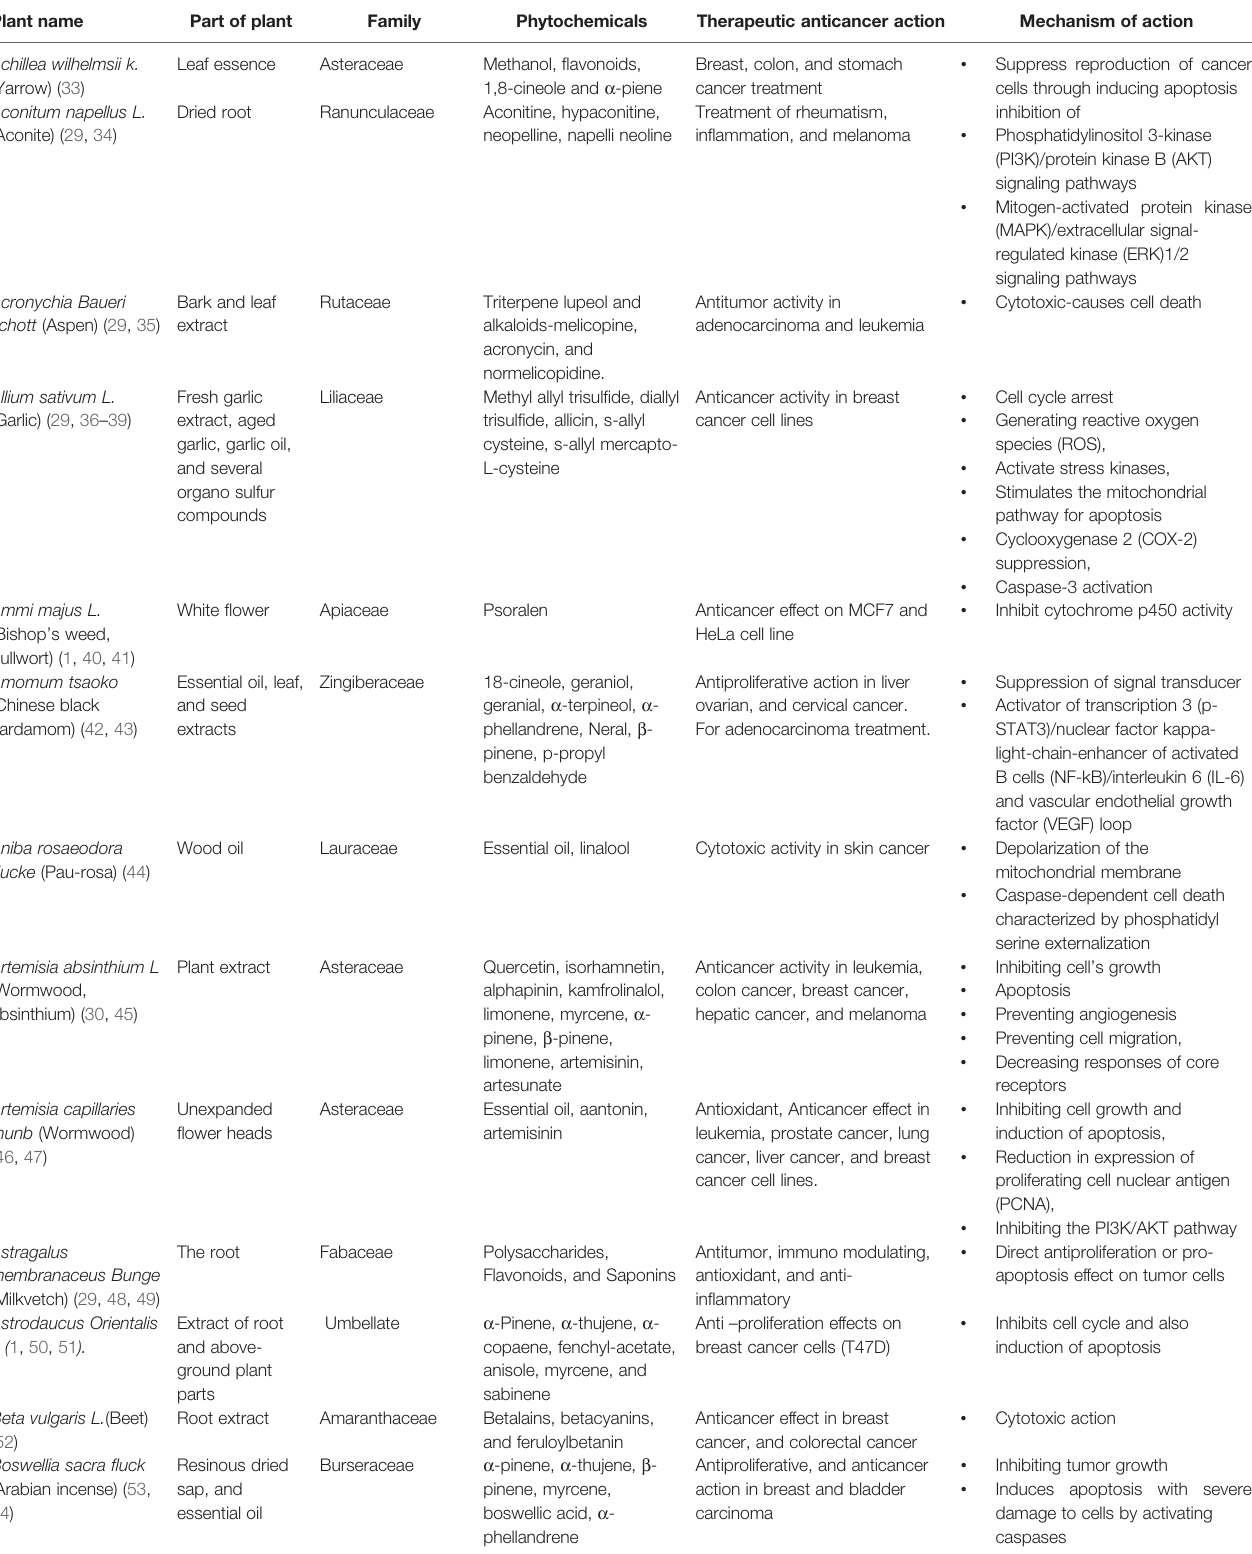
TABLE 1 | Herbal plants with anticancer